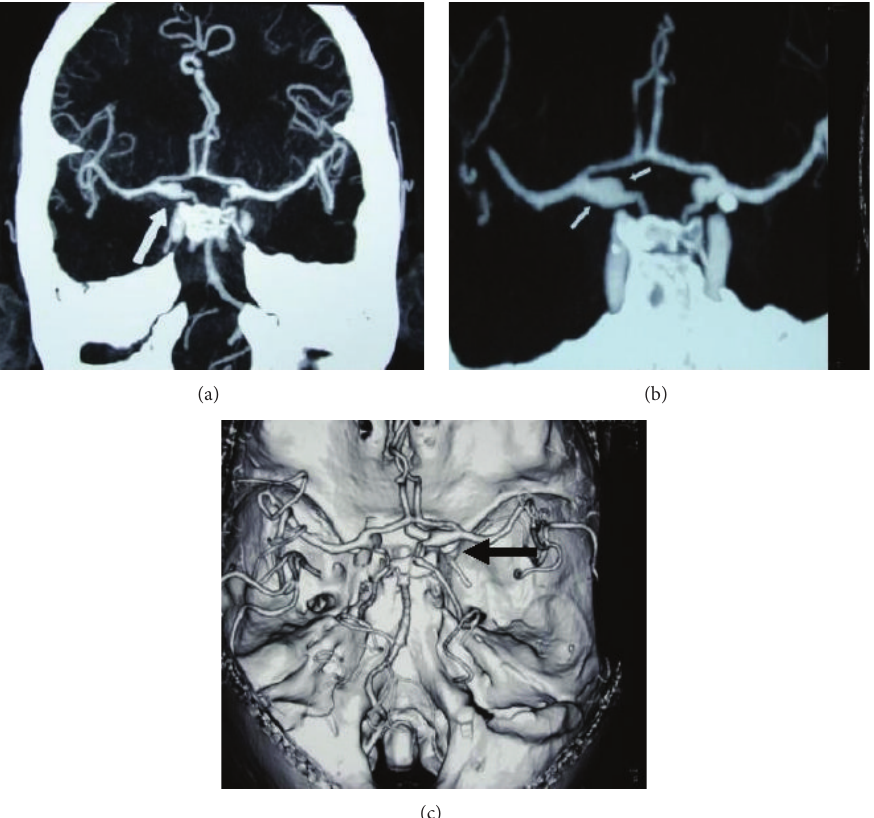
Figure 3: CTA brain showing PCom artery aneurysm. (a) CTA: an aneurysm arising from origin of right posterior communicating artery (PCom) (white arrow); (b) CTA: the aneurysm measured 11mm in larger dimension with a broad-base/neck of 5 mm and a dome of 3.5 mm (whitearrows);(c)vascularreconstruction:rightPComaneurysmonvascularreconstructionimaging(arrowhead)withprominentipsilateral PCom and correspondingly small/hypoplastic ipsilateral P1 of PCA (posterior cerebral